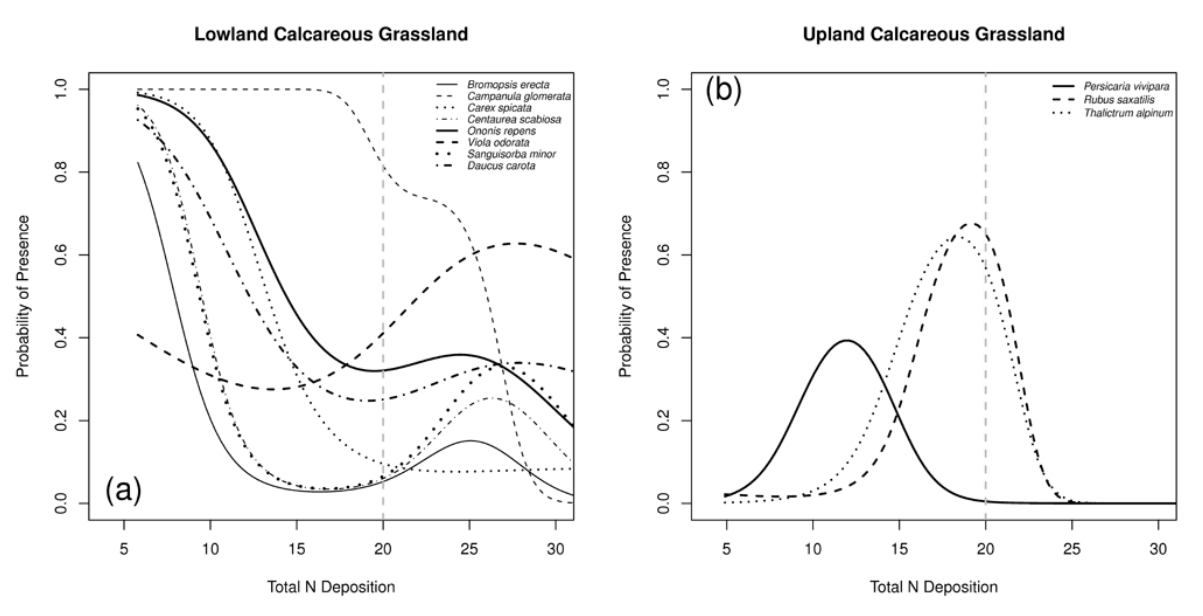
Fig. 3. Change in probability of presence for species showing statistically significant relationships to N deposition in calcareous grasslands in the BSBI local change survey data against increasing total inorganic N deposition (kgNha − 1 yr − 1 ) . The dashed grey line indicates the midpoint of the critical load range for calcareous grasslands as defined by Bobbink and Hettelingh (2011).